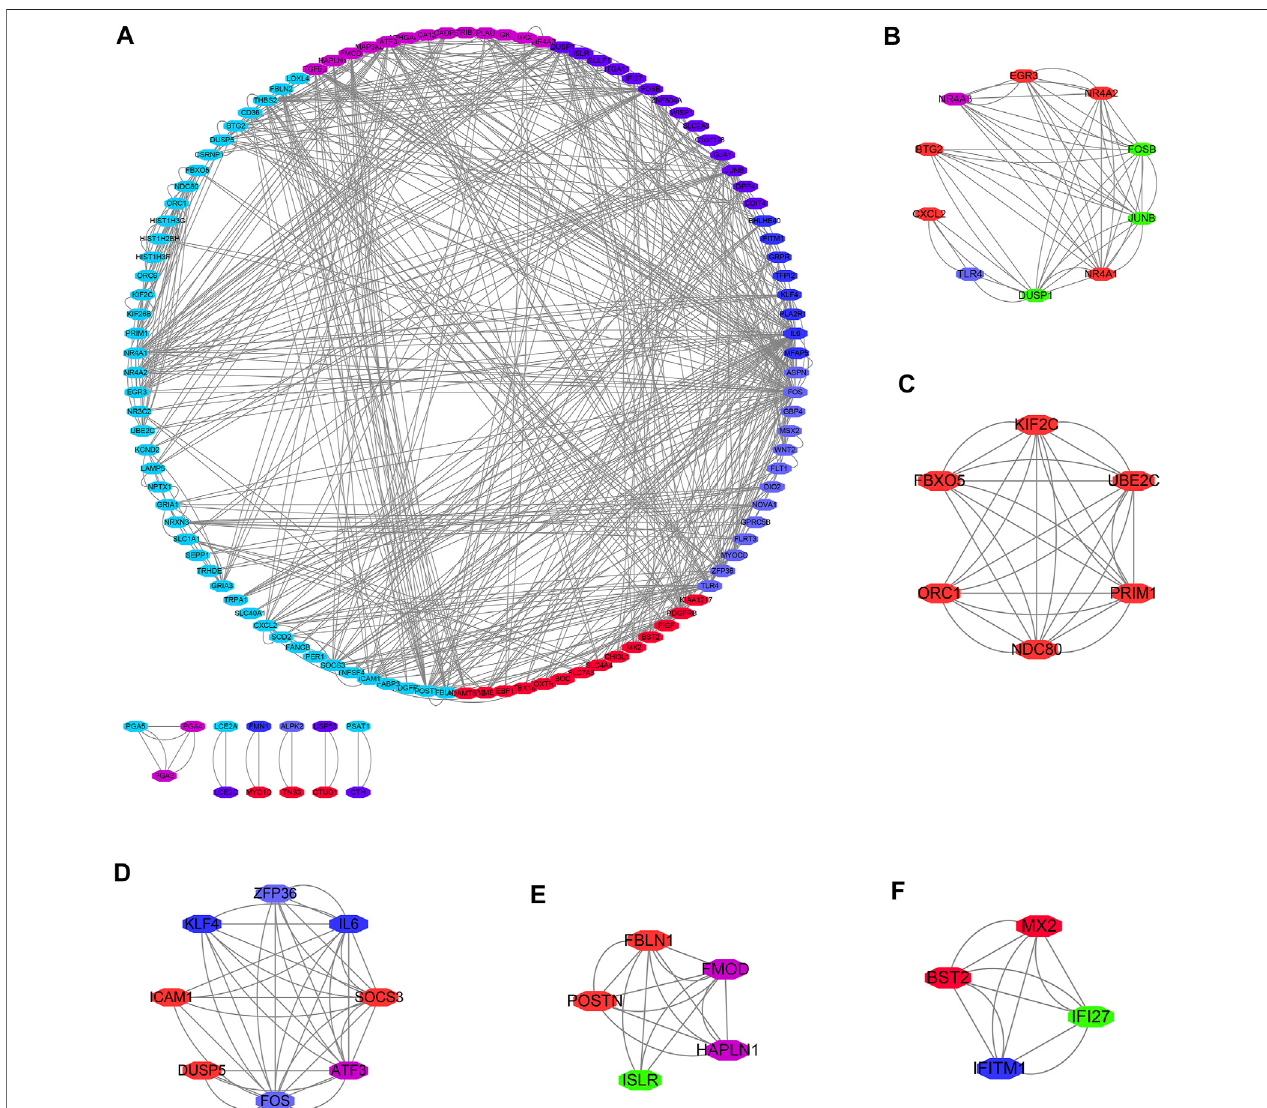
FIGURE 2 | PPI network of DEGs of MSCs. (A) PPI network; (B – F) Cluster of PPI network obtained via the MCODE plug-in of Cytoscape. PPI, Protein-protein interaction; MSCs, Mesenchymal stem cells; DEGs, differentially expressed